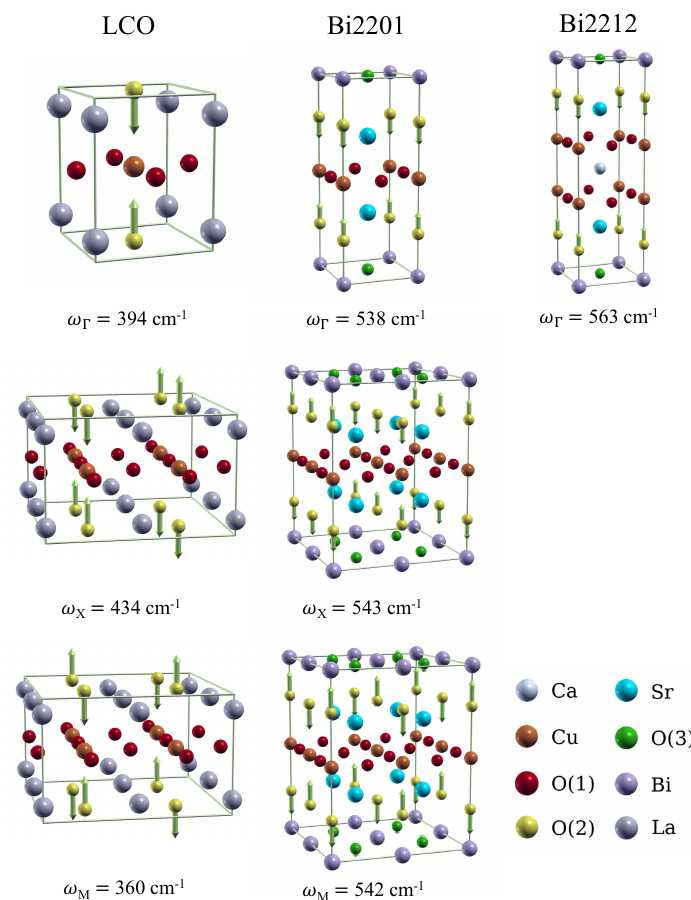
Figure 3: Cu-O apical oxygen modes for La Bi Sr CaCu 2 2